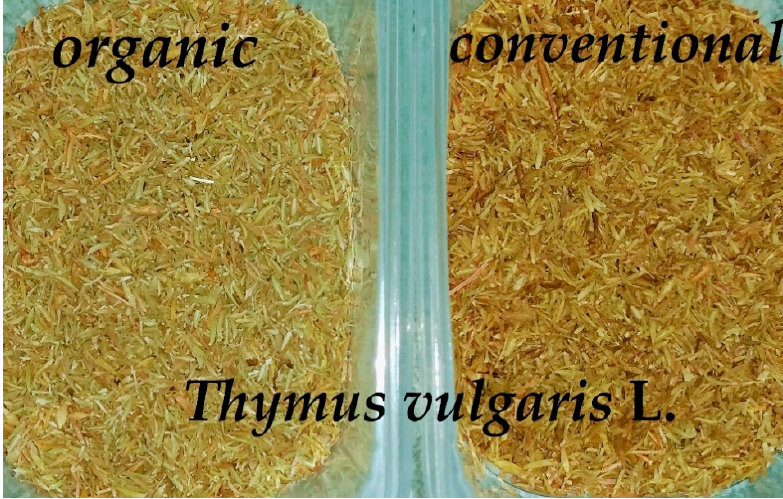
Figure 2. Comparison of colors of dry thyme from organic and conventional cultivation.